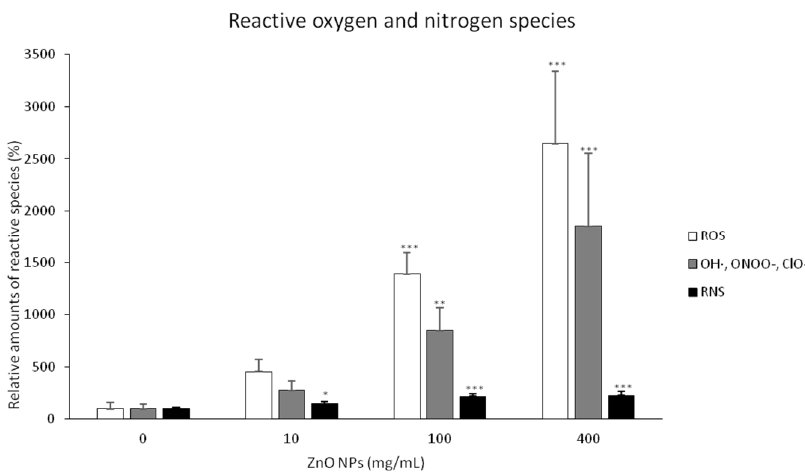
Figure 4. Formation of reactive oxygen and nitrogen species induced by ZnO NPs 72hrs after the treatment. Changes in the amount of ROS were expressed as hydroxyl (white column), hydroxyl radicals, peroxynitrite, and hypochlorite anions (grey column), and reactive nitrogen species as nitric oxide (black column). Each bar represents the mean of three independent experiments. * indicates a significant di ff erence between BY-2 cells treated with ZnO NPs and the corresponding control (untreated) BY-2 cells at p < 0.05, ** indicates a significant di ff erence between BY-2 cells treated with ZnO NPs and the corresponding control (untreated) BY-2 cells at p < 0.01, *** indicates a significant di ff erence between BY-2 cells treated with ZnO NPs and the corresponding control (untreated) BY-2 cells at p < 0.001. Bars represent standard deviations.